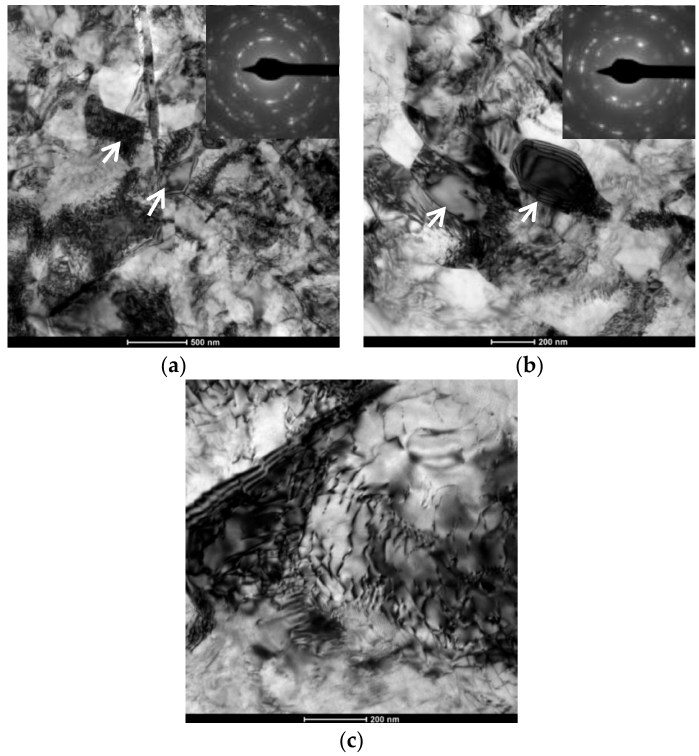
Figure 4. TEM (Transmission electron microscope) micrographs and corresponding SAED (Selected area electron diffraction) patterns of ECAP CP-Ti: ( a ) 4 passes; ( b ) 8 passes; ( c ) dislocations in 4 passes ECAP sample.